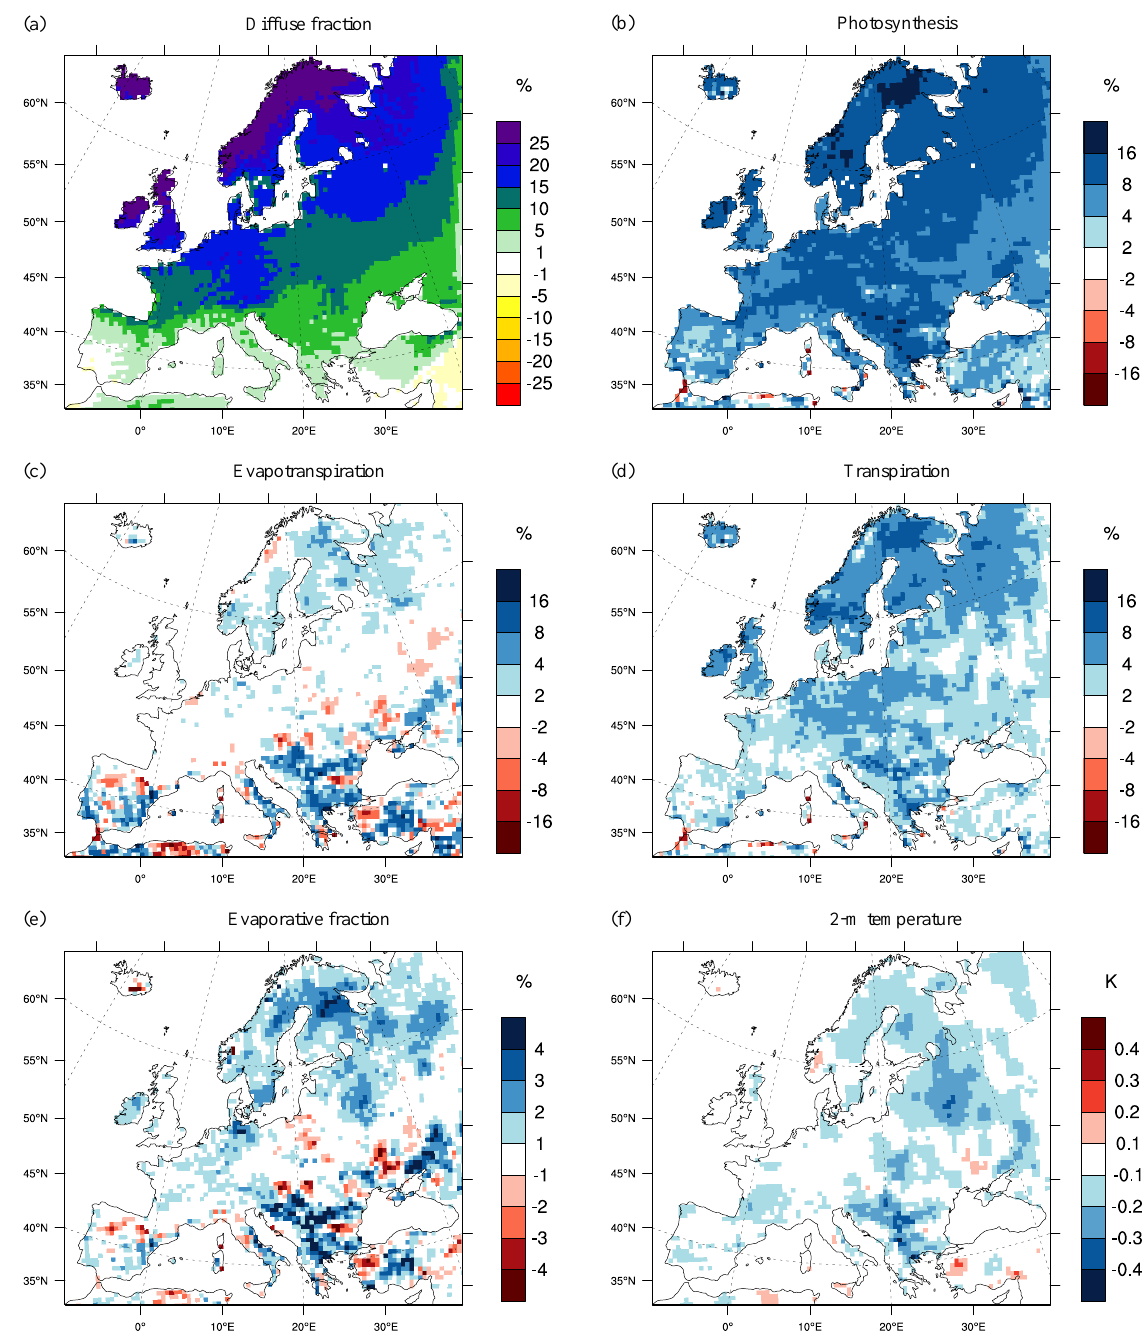
Fig. 7. Summer (JJA) mean change (v4.8-CLM3.5-dif minus v4.8-CLM3.5) for a) diffuse fraction (%), b) photosynthesis (relative change), c) evapotranspiration (relative change), d) transpiration (relative change), e) evaporative fraction (%) and f) 2-meter temperature (K). The considered time period is 1986-2006.